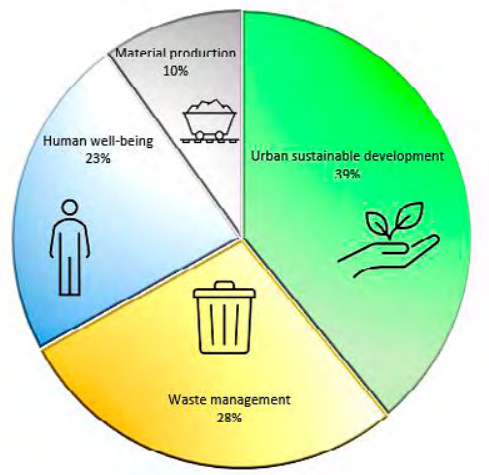
Figure 3. Percentage distribution of the studies reviewed by research